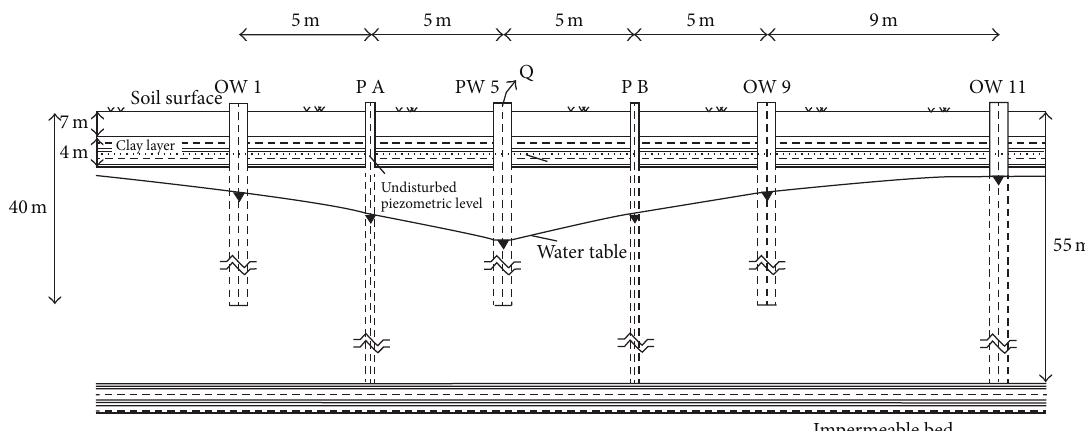
Figure 4: Behavior variation of the aquifer considered from confined to unconfined during the pumping.